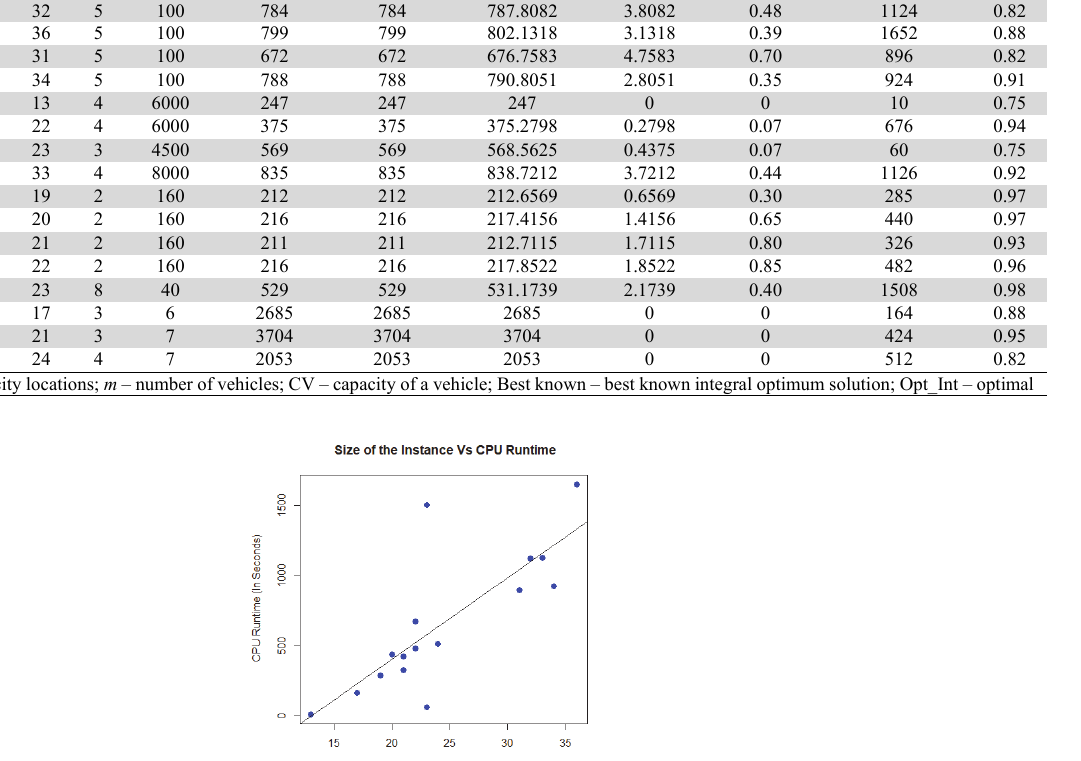
Table 2 Comparison of LSA results with known integral optimum for CVRP instances Instance